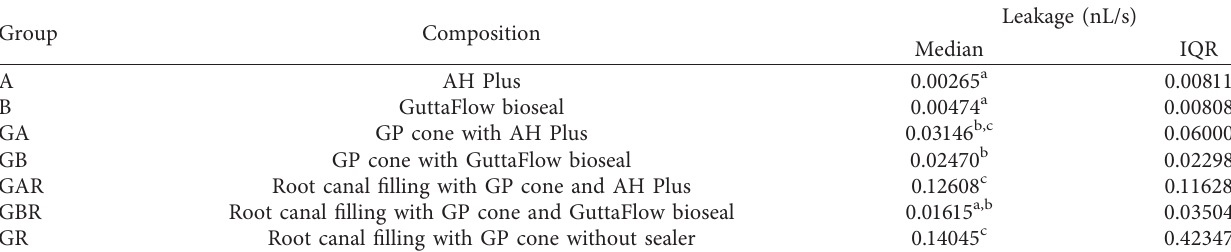
Table 2: Median and interquartile range (IQR) of leakages.